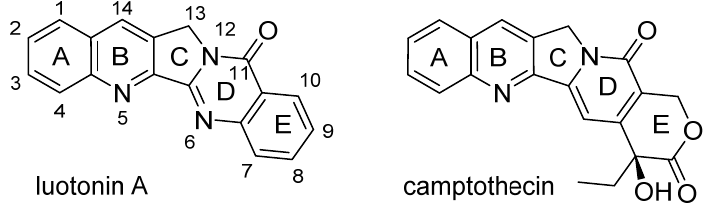
Figure 3. Structures of luotonin A and camptothecin (CPT).